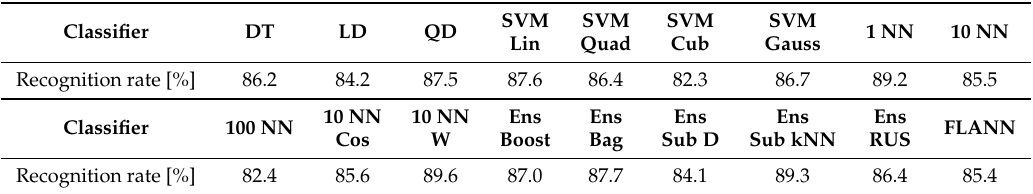
Table 8. Leave-one-subject-out cross-validation results for the dataset 2.